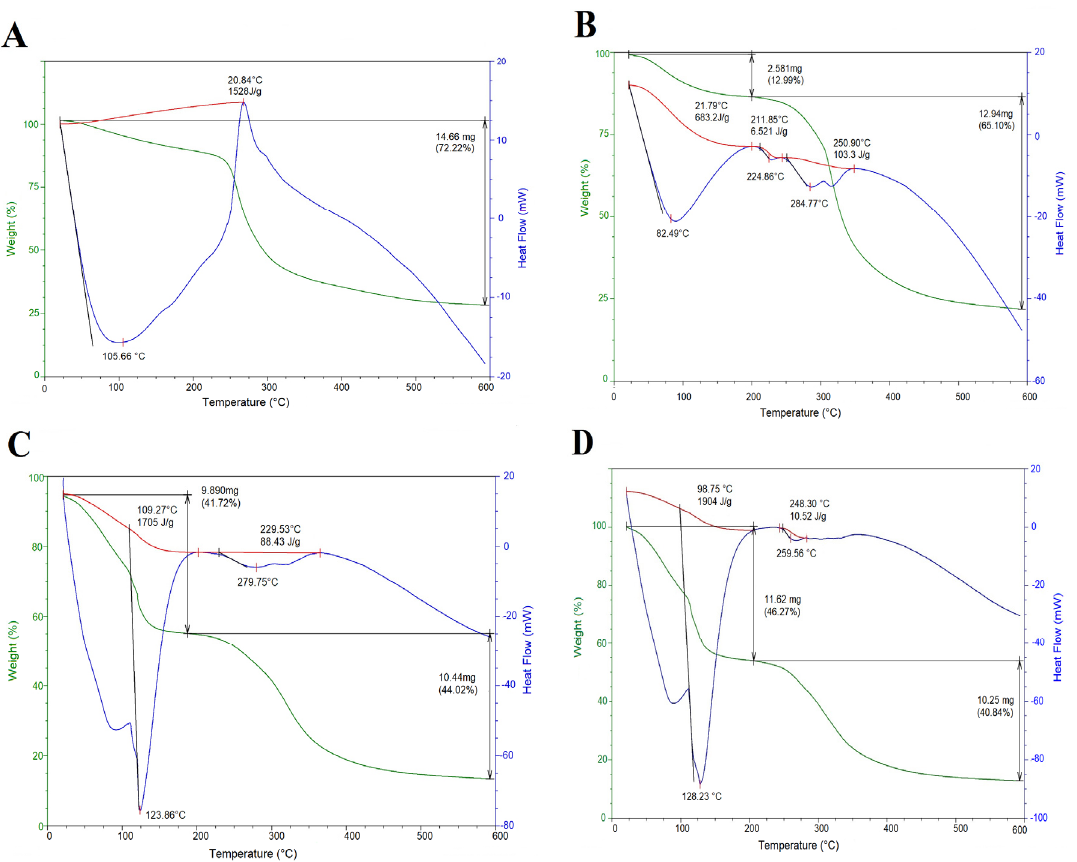
Figure 4. Representative DSC / TGA curves: ( A ) cactus mucilage (CM), ( B ) gelatin, ( C ) composite capsule and ( D ) control capsule.